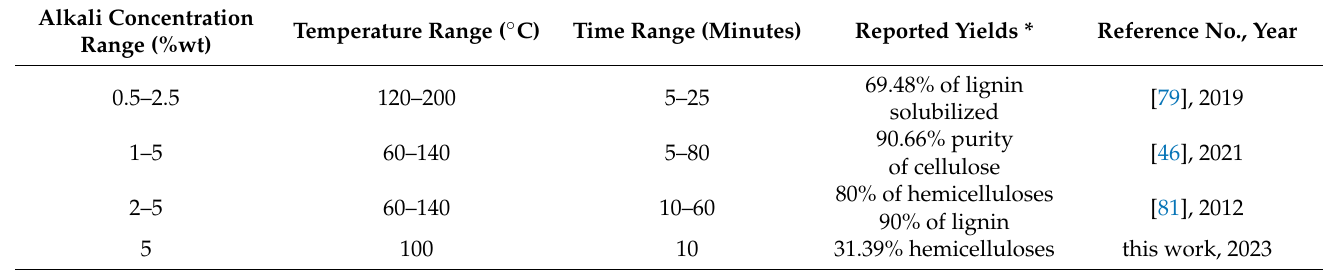
Table 8. Comparison of MW-assisted wheat straw alkaline extraction.